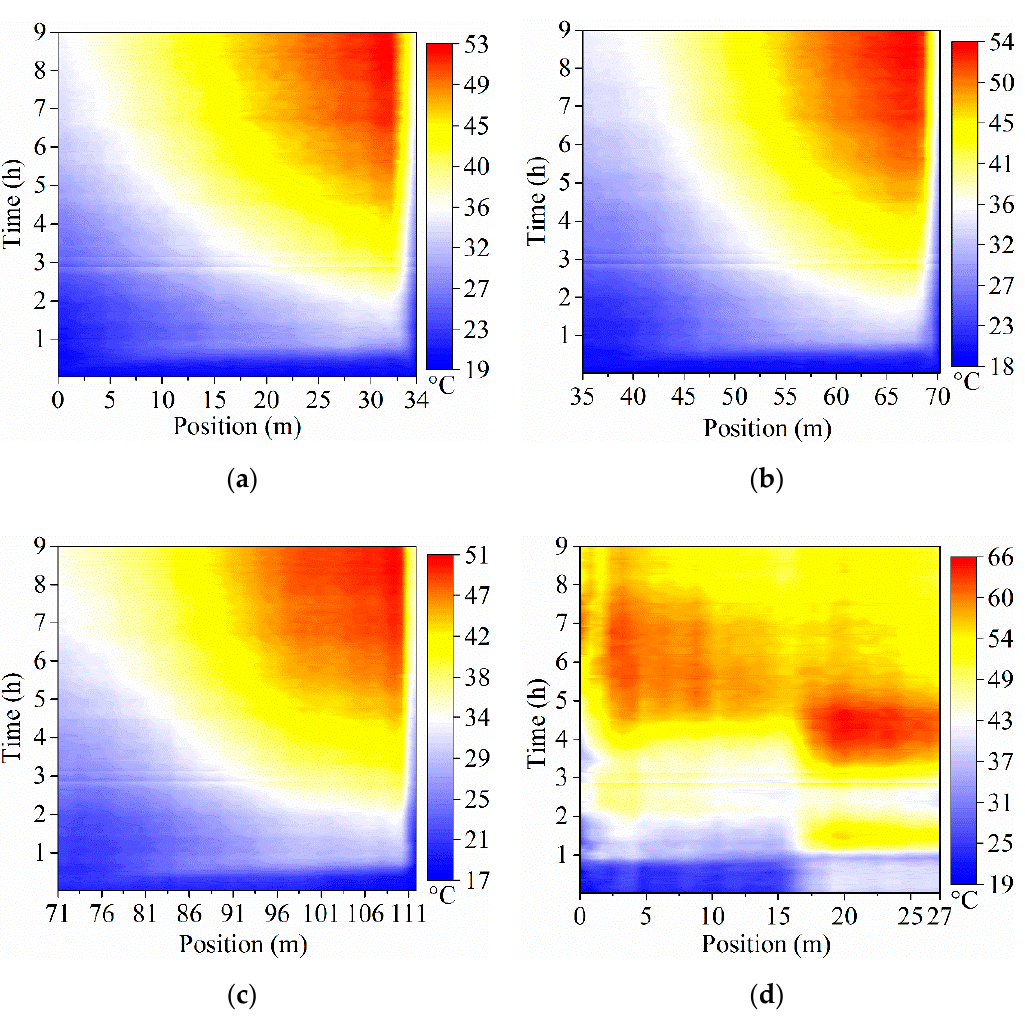
Figure 10. Spatiotemporally continuous temperature distribution along the ( a – c ) iron core limbs, phase A, B, and C, respectively and ( d ) inside wall of the oil tank.